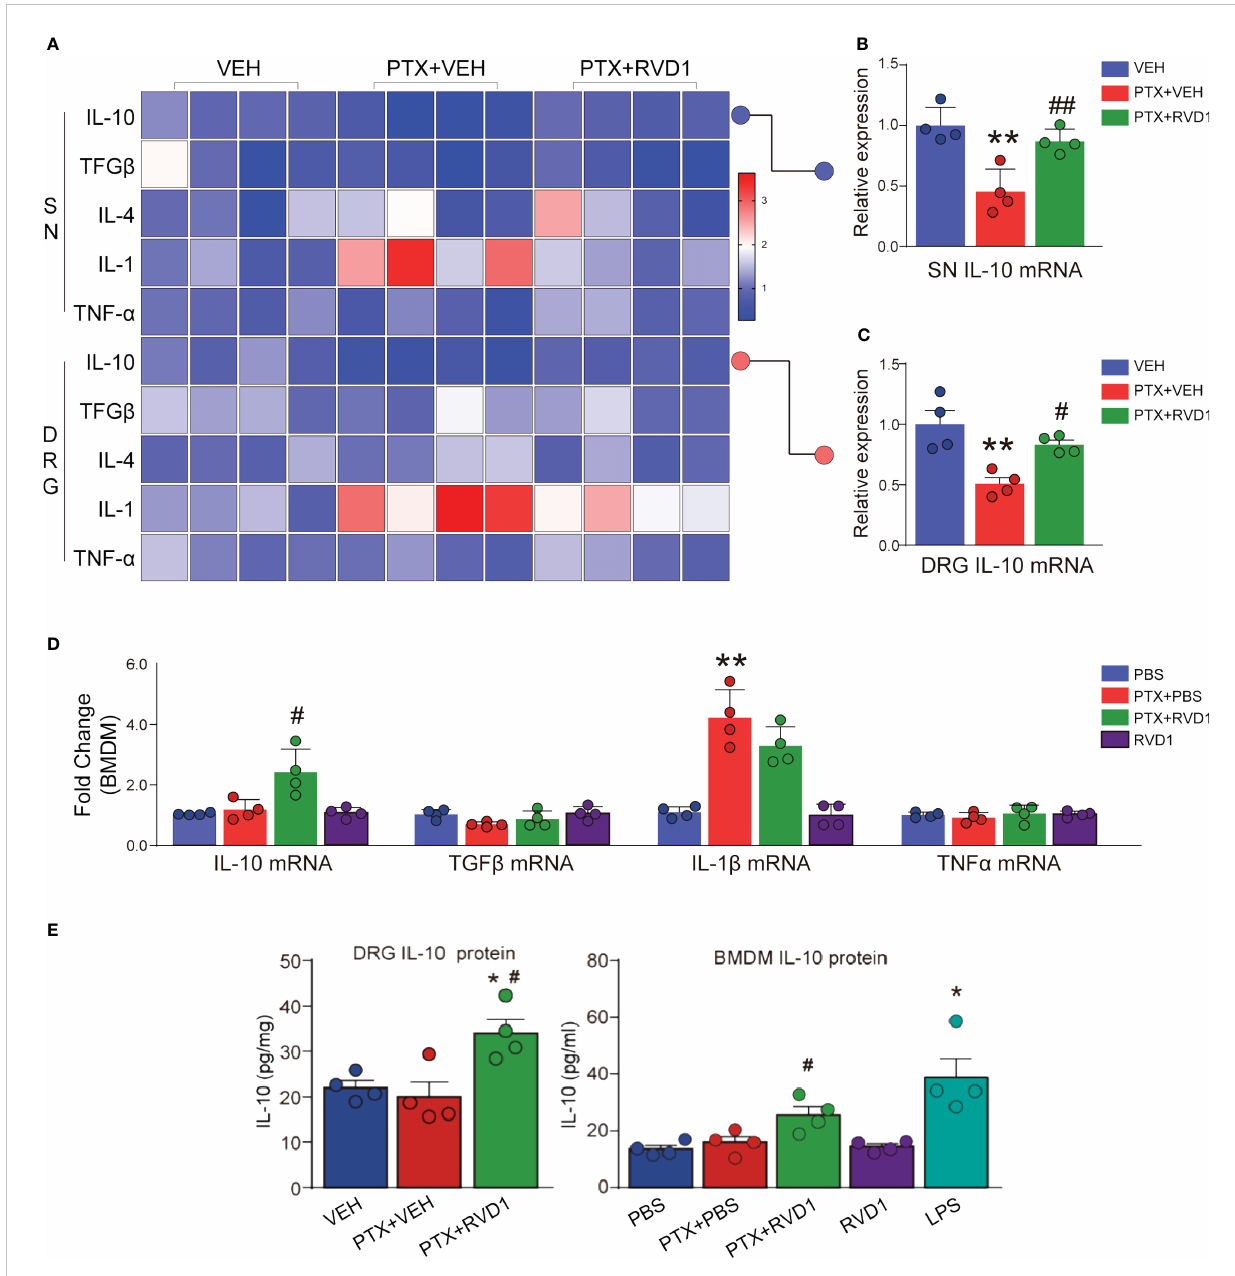
FIGURE 5 The effect of RvD1 on the expression of in fl ammatory factors. The in fl ammatory factors IL-10, IL-4, TGF- b , IL-1 b , TNF- a in DRG and SN tissues of mice were detected by qPCR 14 days after PTX injection (A – C) . BMDMs were pretreated with 250 nm RvD1 for 3h and then treated with 1 m M PTX for 24 h, the expression of in fl ammatory factor mRNA was detected by qPCR (D) . IL-10 protein was determined by ELISA (E) . *p < 0.05, **p < 0.01 vs VEH or CON group; #P< 0.05, ##p< 0.01 vs PTX group. n=4. RvD1, resolvin D1; PTX, paclitaxel; VEH,